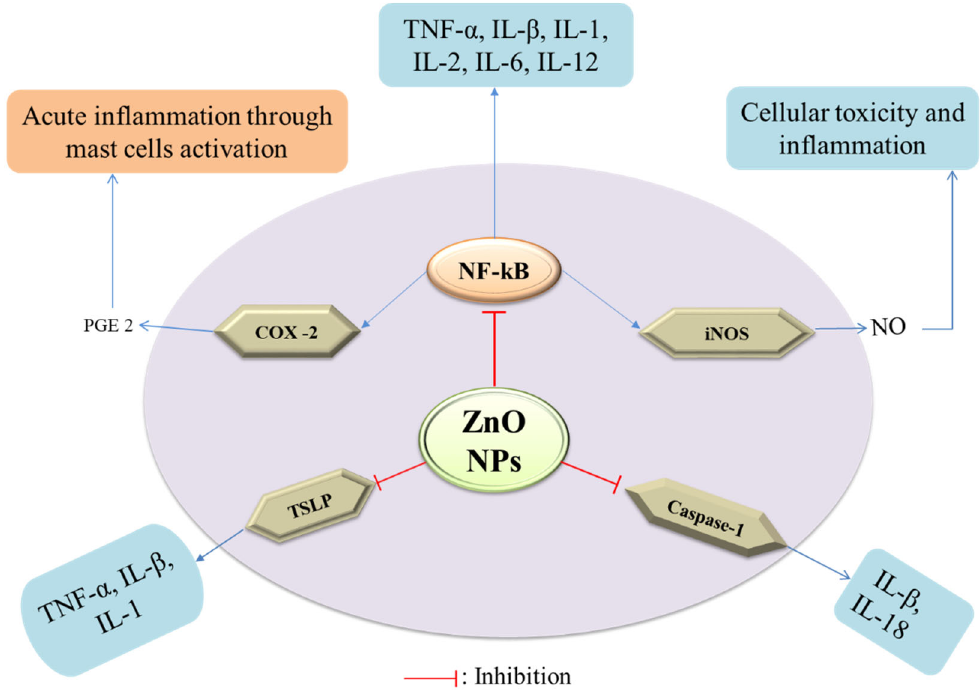
Figure 4. Mechanism of anti-inflammatory potency of ZnO − NPs.